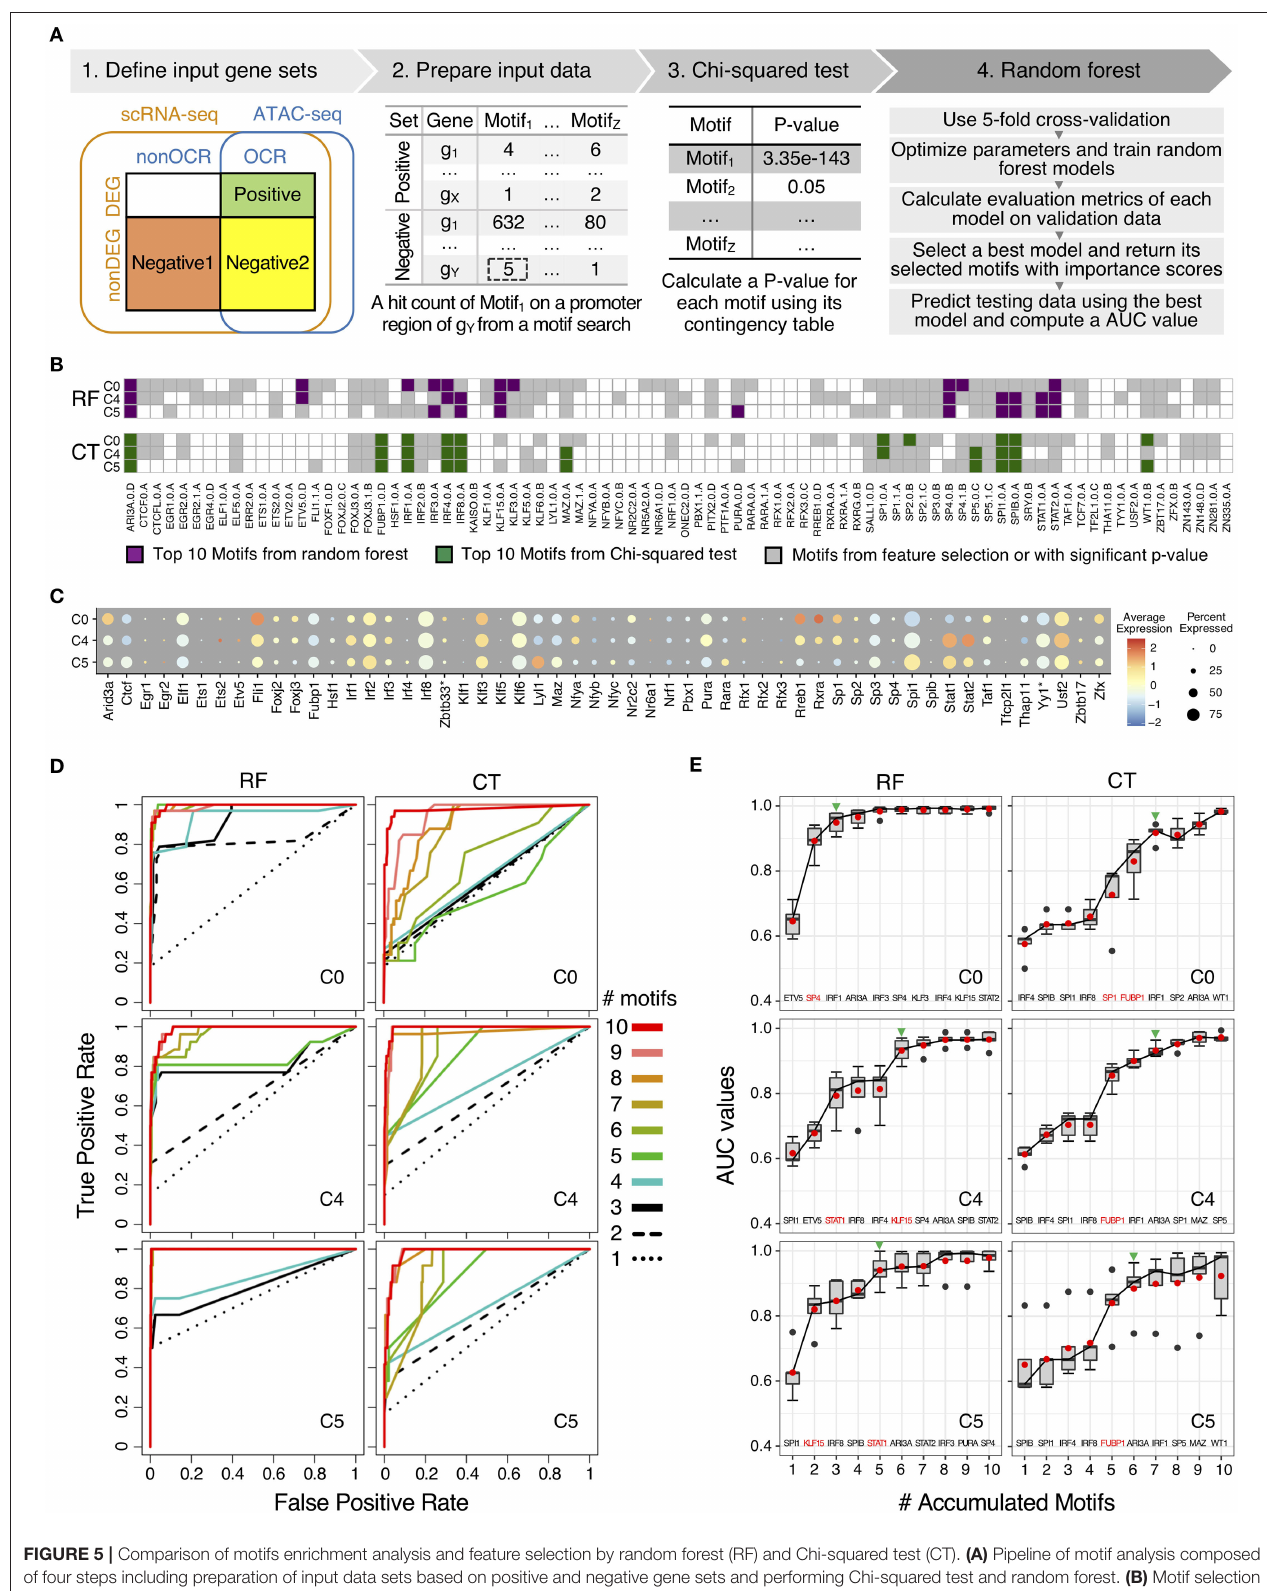
FIGURE 5 | Comparison of motifs enrichment analysis and feature selection by random forest (RF) and Chi-squared test (CT). (A) Pipeline of motif analysis composed of four steps including preparation of input data sets based on positive and negative gene sets and performing Chi-squared test and random forest. (B) Motif